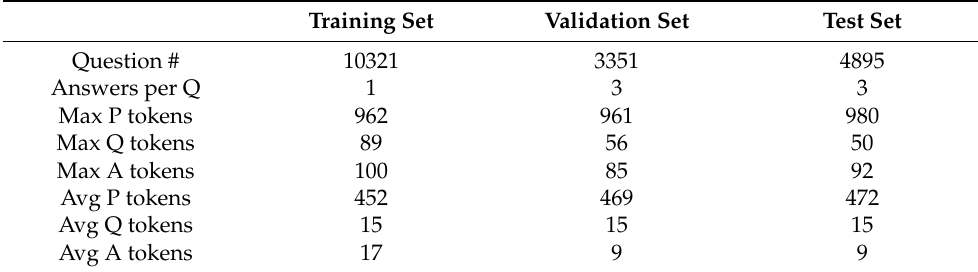
Table 1. Scale statistics of the CMRC2018 dataset.